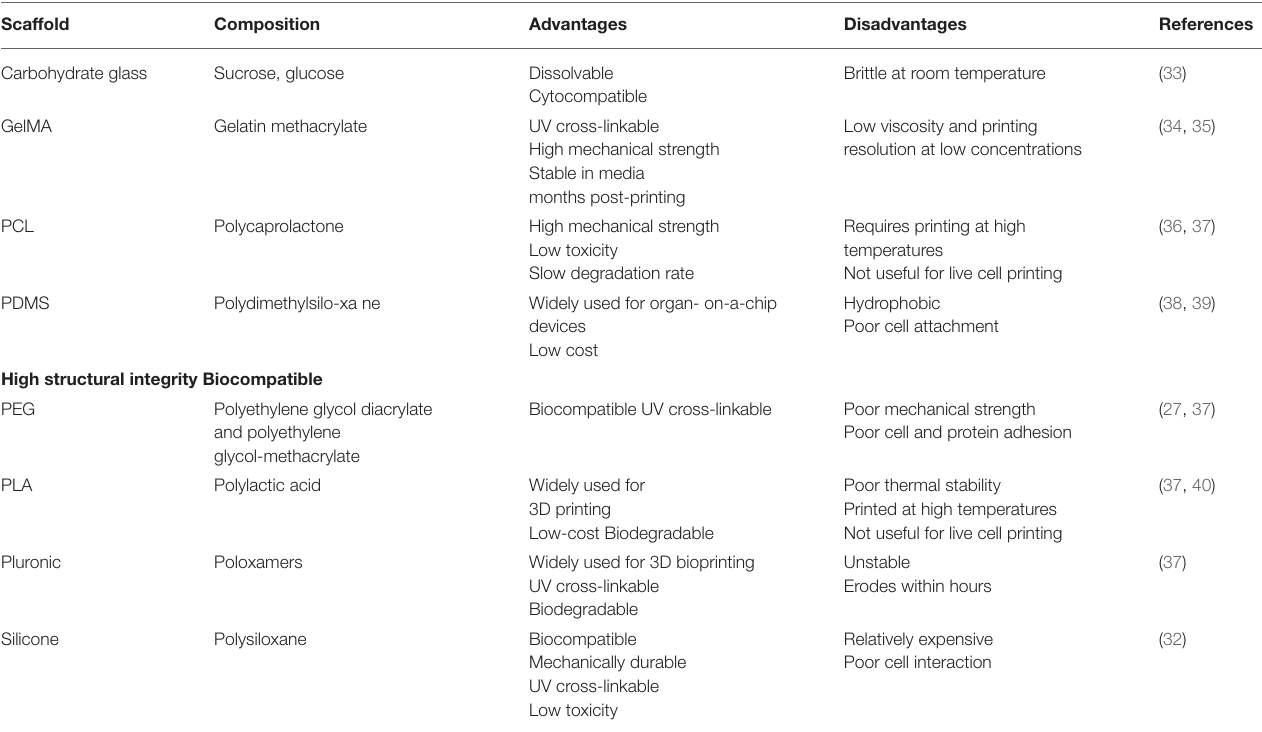
TABLE 3 | Properties of common non-biological